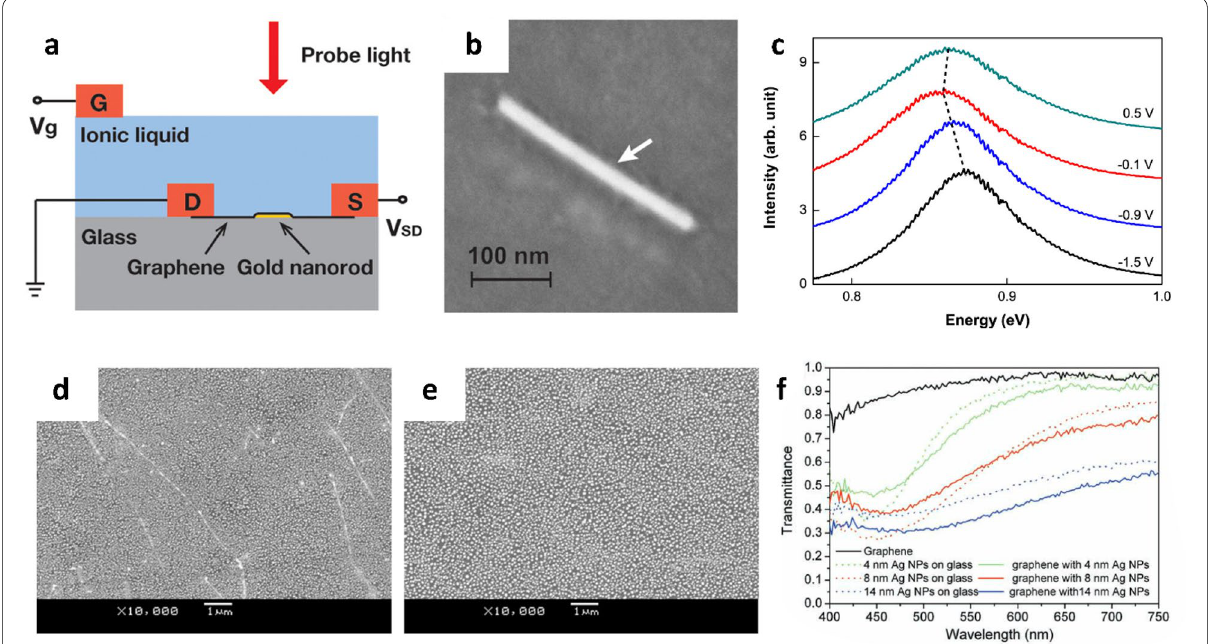
Fig. 6 Tunability of graphene-based plasmonic materials. a–c Electrical tunability of graphene/Au nanorod hybrid structure. a Schematic diagram of a graphene/Au nanorod hybrid structure gated through ionic liquid. A top electrolyte gate was used to control plasmon resonance of the hybrid system by varying optical transitions in graphene. b A high-resolution scanning electron micrograph (SEM) image of the graphene/single Au nanorod. Graphene draped over the nanorods (white arrow). c Rayleigh scattering spectra of the graphene/Au nanorod structure at 0.5, and 1.5 V of gate voltage. The plasmon resonance shifted depending on the gate voltage. Reprinted with permission from [99]. Copyright 2012 − American Chemical Society. d , e Structural tunability of AgNPs/graphene hybrid structure. AgNPs with d 49.3 nm and e 67.5 nm of lateral dimension on graphene formed through thermal annealing of 4 and 8 nm thick Ag films, respectively. f Transmittance spectra taken on graphene (black) and AgNPs/graphene hybrid structures (colored solid lines). SPR of AgNPs/graphene structures redshifts with increasing lateral size of the AgNPs. The 4, 8, and 14 nm AgNPs in label indicate the thickness of as-deposited Ag film which were transformed to AgNPs with 49.3, 67.5, and 147.5 nm of lateral size, respectively, after dewetting. Reproduced with permission from [103]. Copyright 2012 WILEY-VCH Verlag GmbH & Co. KGaA,